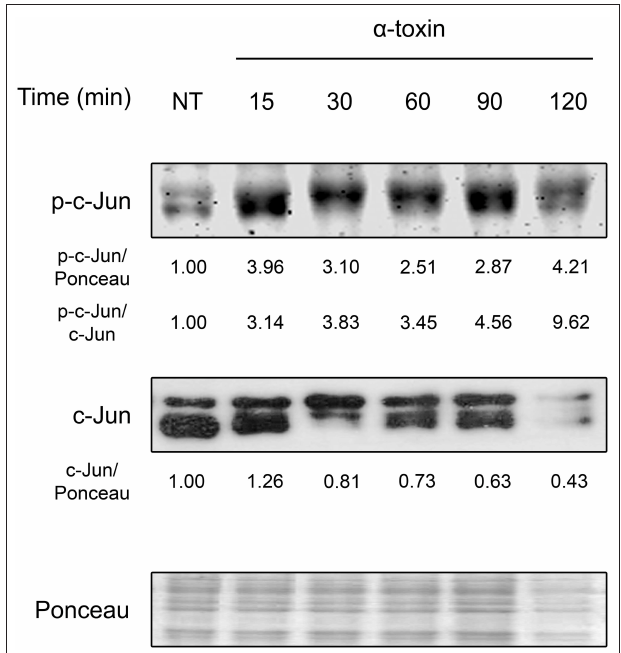
FIGURE 1 | Activation of c-Jun by staphylococcal α -toxin. Proteins were extracted from cultures of lung epithelial A549 cells which had been treated with α -toxin (5 µ g ml-1) for 15–120min or left untreated (NT). Western Blots were performed with specific antibodies against the phosphorylated and total fractions of c-Jun. Ponceau staining of total transferred proteins were used as loading controls. The panels illustrate typical blots obtained. Below the panels, relative protein levels are shown, with NT values normalized to